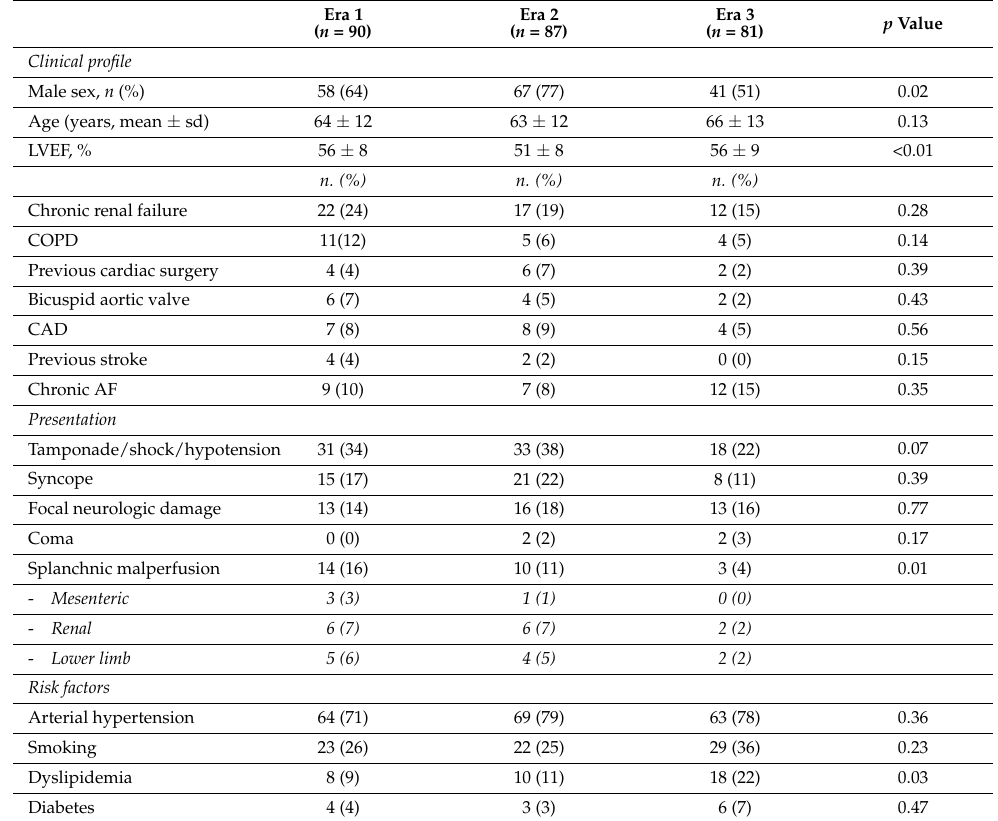
Table 1. Baseline